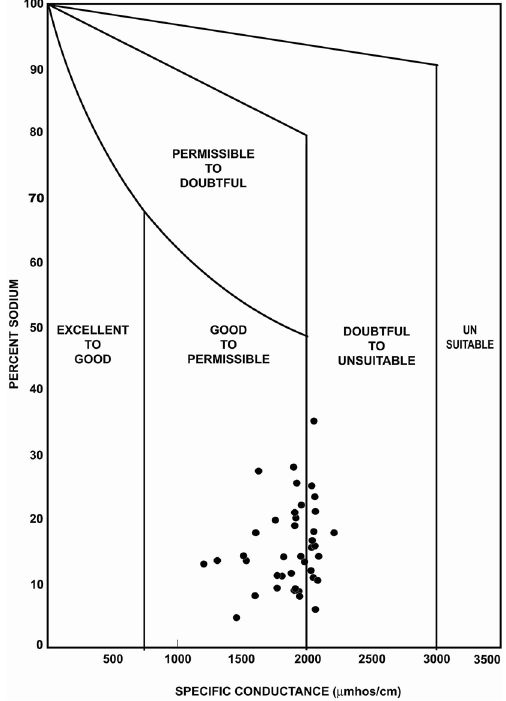
Fig. 6 Quality of water in relation to electrical conductivity and per cent sodium (Wilcox